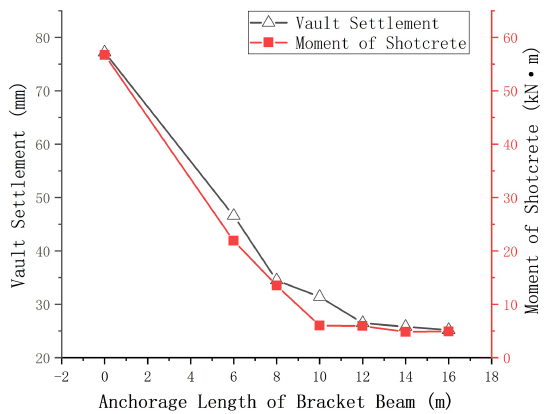
Table 6. Numerical results.